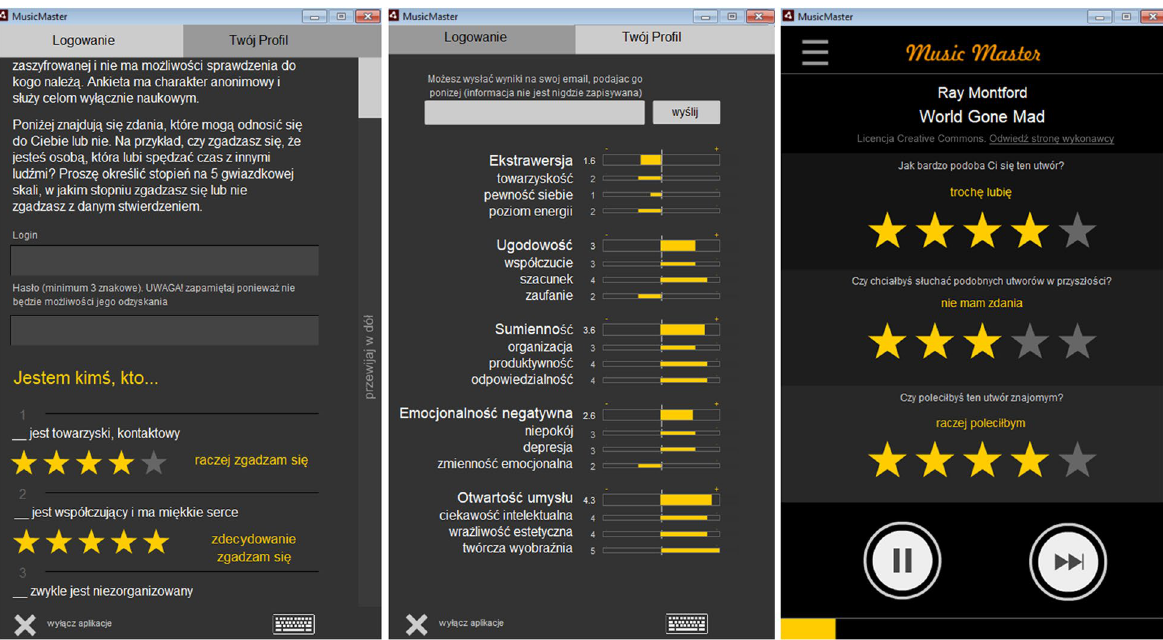
Fig. 1 The main screens of the Music Master application used in the experiments. The left screen shows the registration process, with 60 questions from the BFI-2 questionnaire. The middle screen displays the intensity of negative and positive poles of the personality dimensions. The right screen presents a music player where the participants can rate the song in terms of three different aspects (cognitive, motivational and social), using a 5-point Likert scale. The application is for Polish users, so the user interface is in